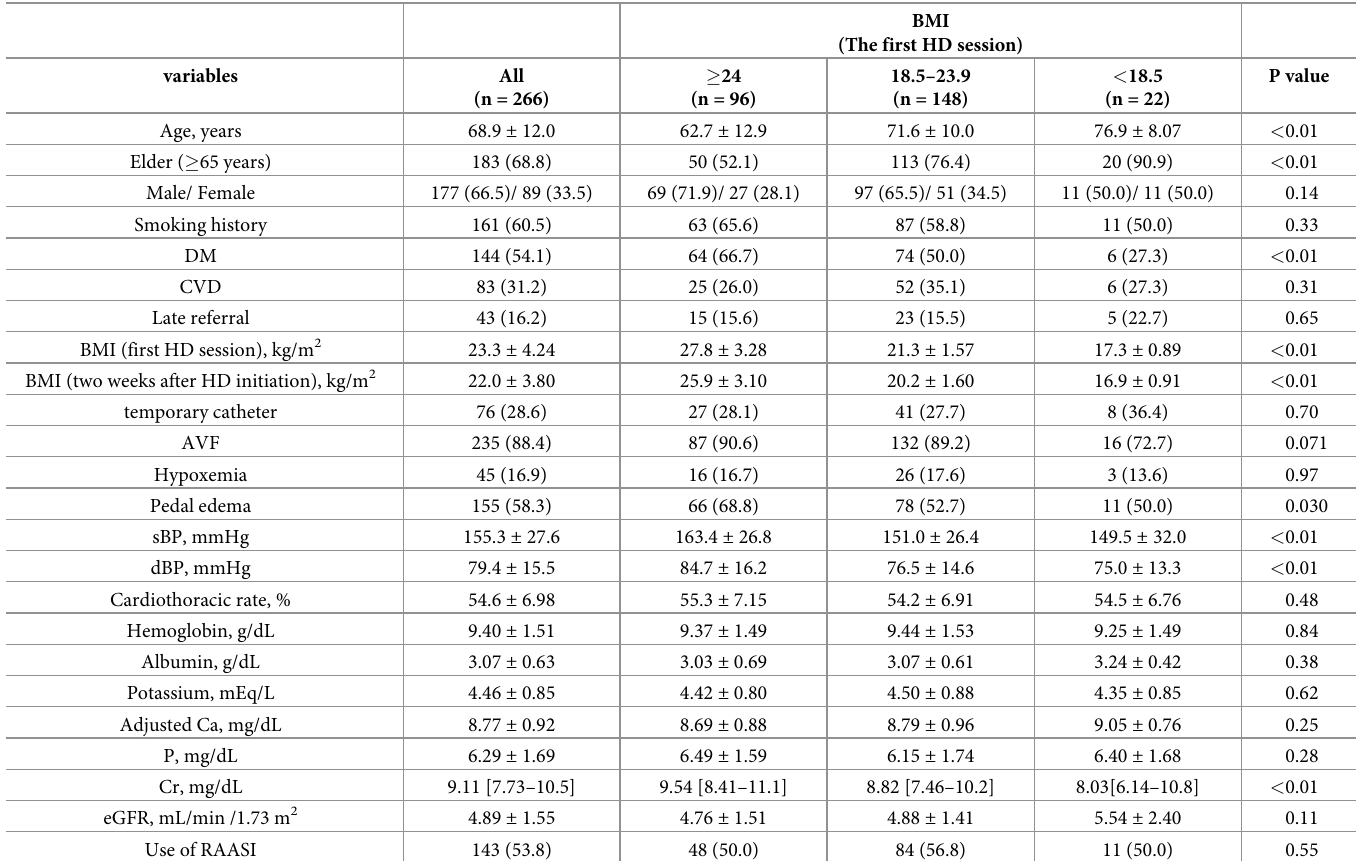
Table 1. Baseline clinical characteristics in 266 patients at the first HD